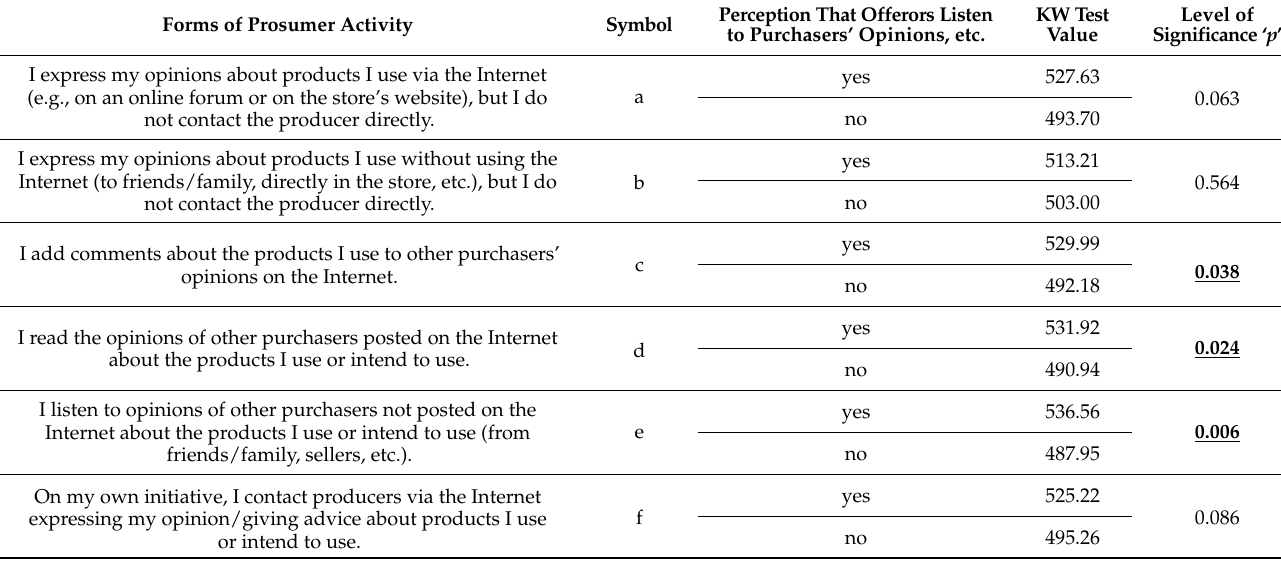
Table 4. Significance of differences between respondents’ opinions regarding forms of prosumer activity according to the perception of offerors as entities that listen to purchasers’